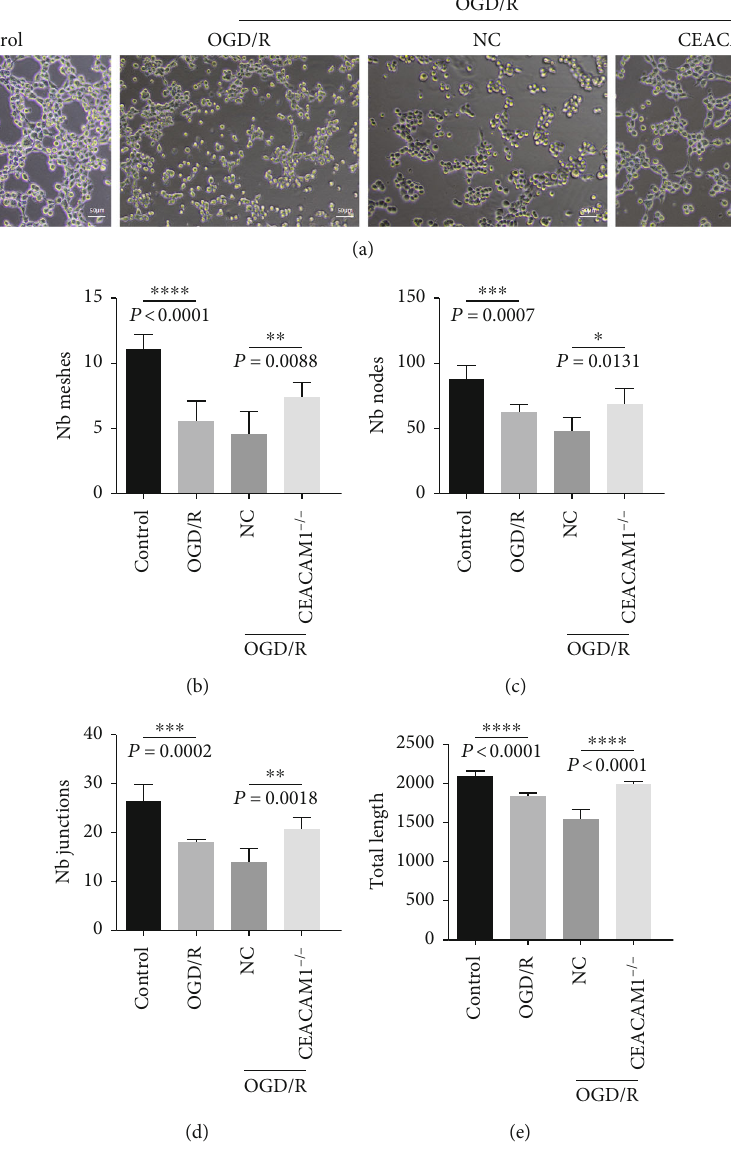
Figure 5: Changes in number of tubes, nodes, intersections, and total length in response to OGD/R, in control and CEACAM1 -/- HPVMECs. (a) Representative fi eld of HPVMECs for each cell type, highlighting tubes measured in the tube formation assay. (b) Number of tubes formed by each cell line during the assay. (c) Number of nodes formed by each cell line during the assay. (d) Number of crossovers formed in each cell line during the assay. (e) Quantitation of tube length in each cell line during the